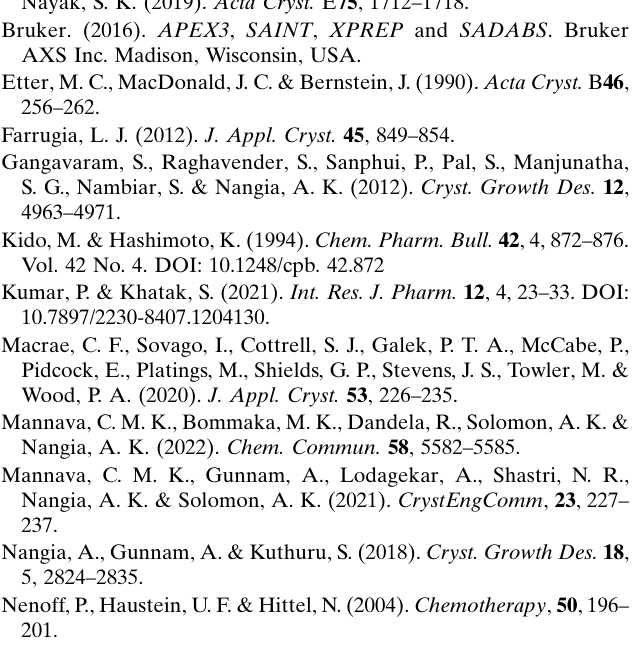
Table 2 Experimental details. Crystal data Chemical